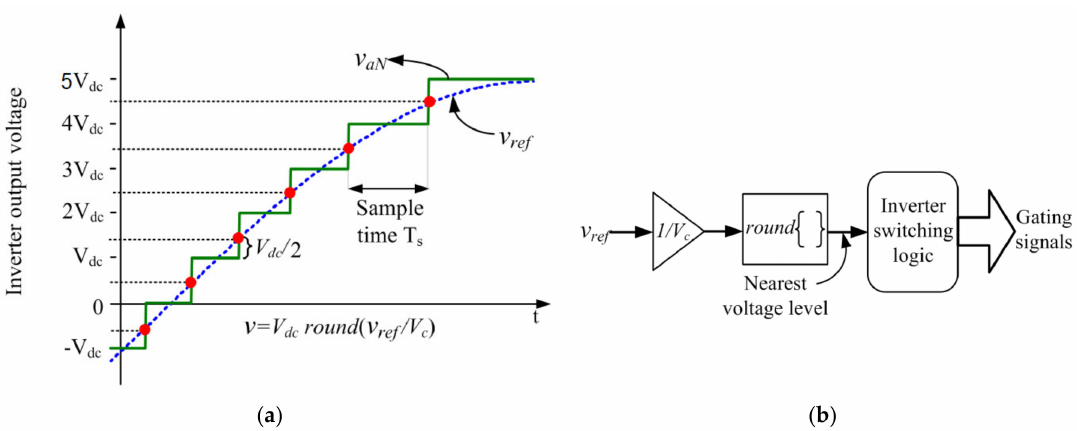
Figure 6. Nearest level control: ( a ) Waveform synthesis; ( b ) Control